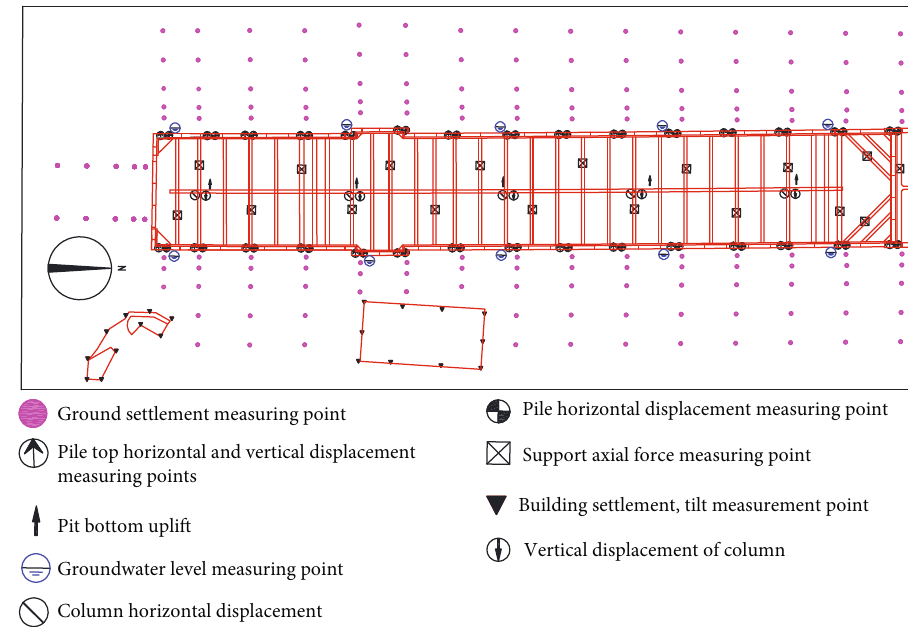
Figure 9: Plan view of typical foundation pit